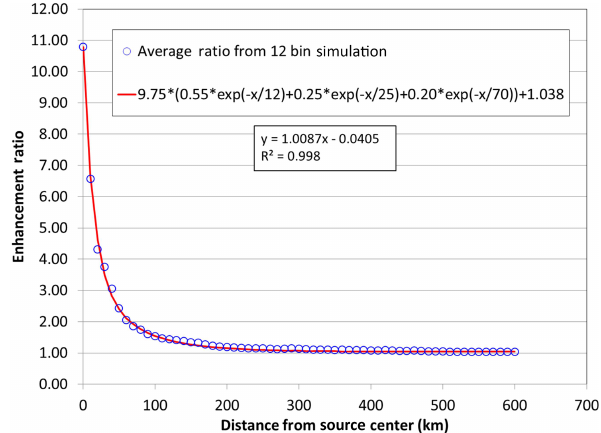
Figure 9. Temporal and spatial average ratio of total deposited crustal material as a function of distance from a reference point within the oil sands emissions region: ratio of deposition from the model simulation using aircraft-based primary particulate emissions to the model simulation using reported fugitive dust